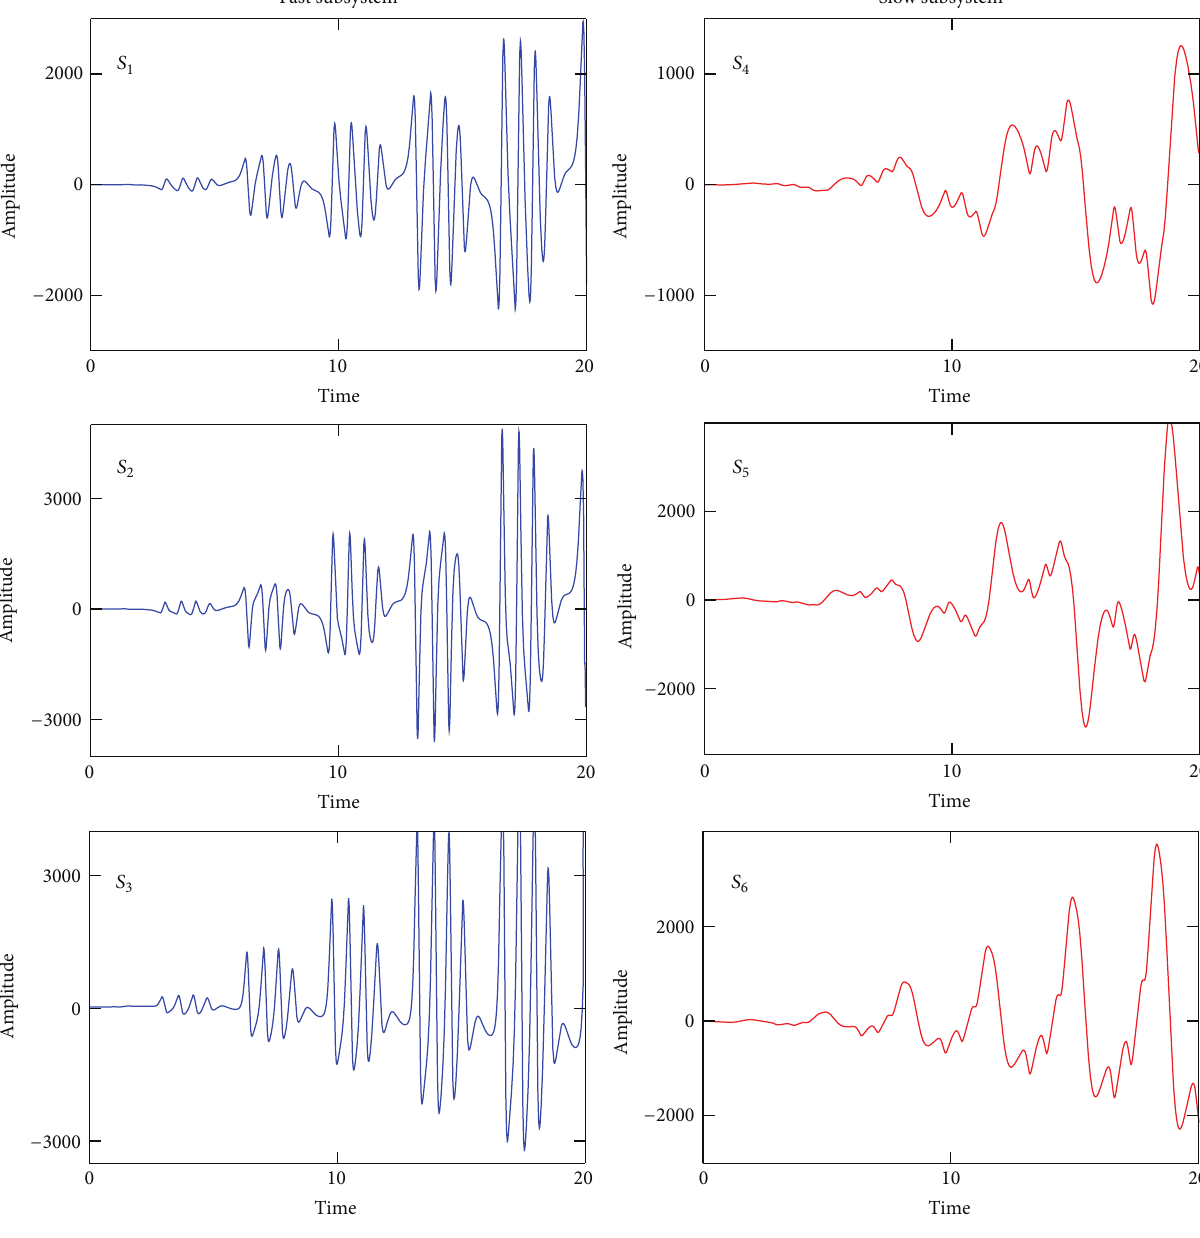
𝑦 , 𝑋 , and 𝑌 with respect to 𝑟 is significantly less than variables 𝑧 and 𝑍